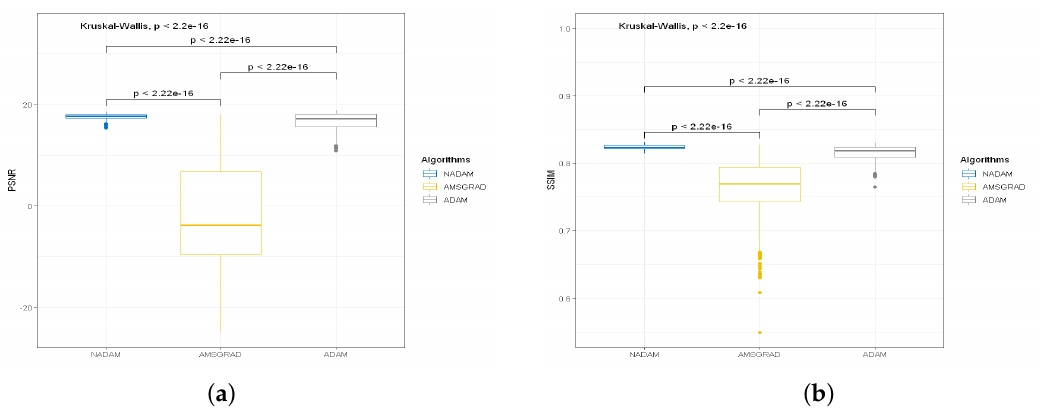
Figure 7. Kruskal–Wallis test for ( a ) PSNR and ( b ) SSIM for different groups of optimizers, with the statistical significance p -value for each group. The simulation cases with PSNR < − 25 db are excluded.